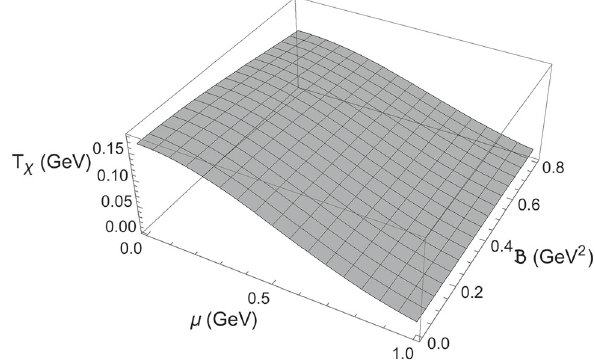
Fig. 3 The chiral phase diagram with magnetic